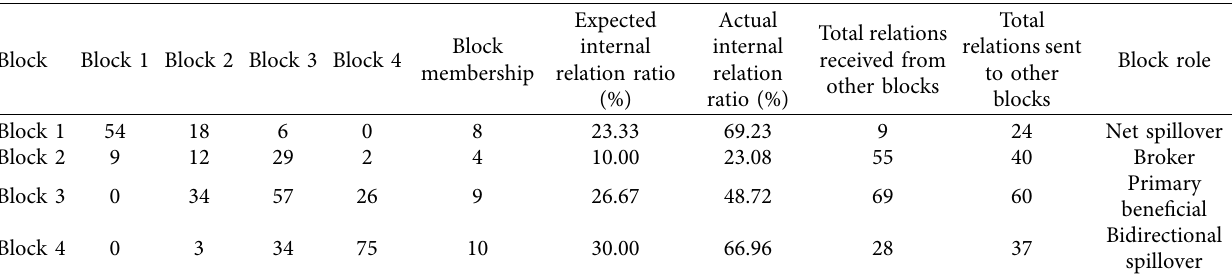
Table 2: Analysis of spillover effects between various blocks.